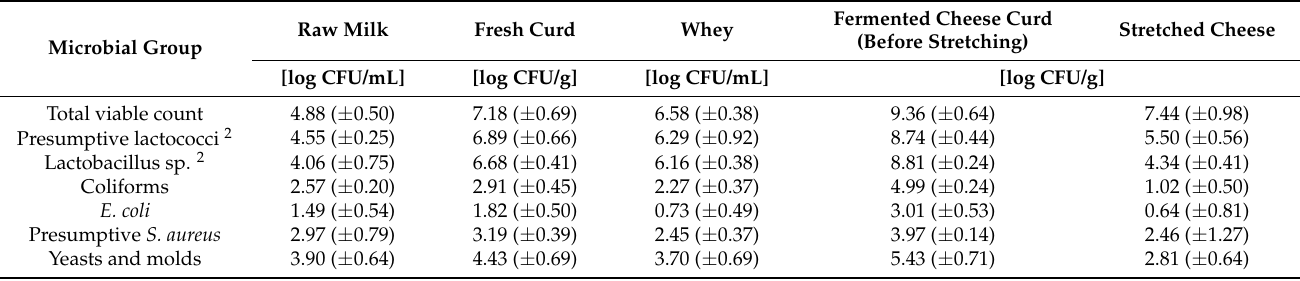
Figure 2. Fitted distributions for microbiological indicators in raw milk: ( a ) total viable count (TVC); ( b ) yeasts and molds (Y&M); ( c ) coliforms (CFM); ( d ) Escherichia coli (EC); ( e ) presumptive Staphylococcus aureus (pSTA). Table 1. The average counts of microorganisms determined in the cheeses produced from raw milk at different process- ing steps 1